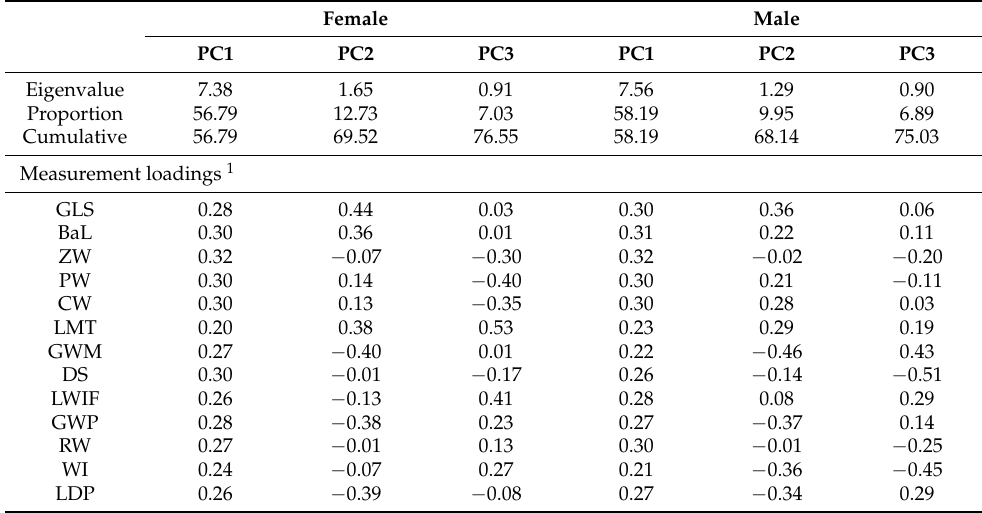
Table 2. Factor loadings of principal component analysis (PCA) in cranial measurements in